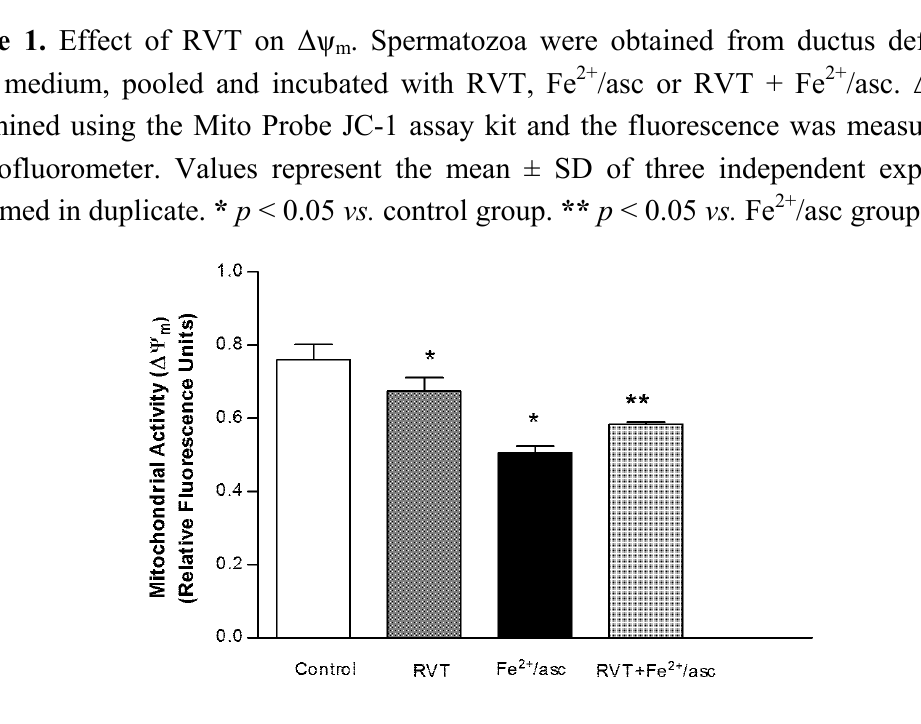
DCFDA reagent. Fluorescence 2